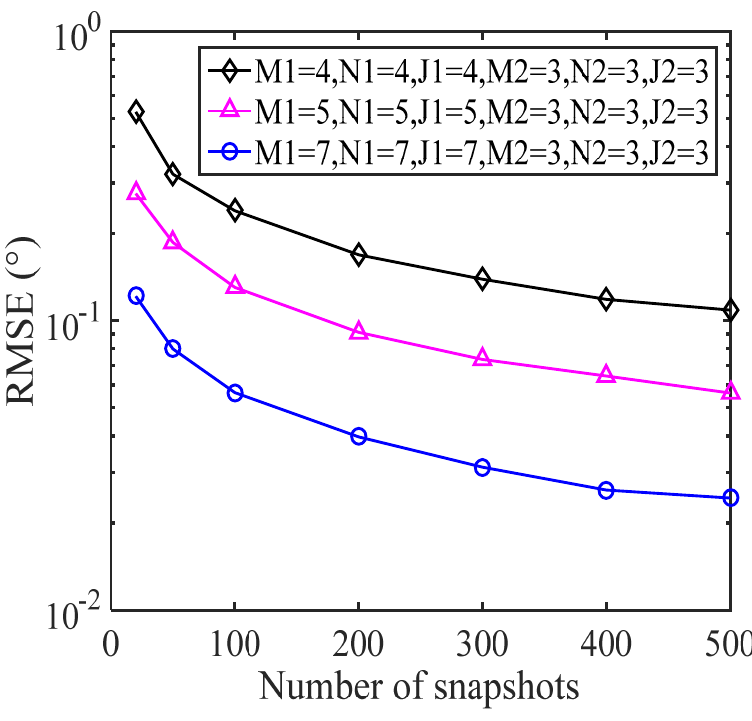
Figure 10. RMSE of various geometries against the number of snapshots.